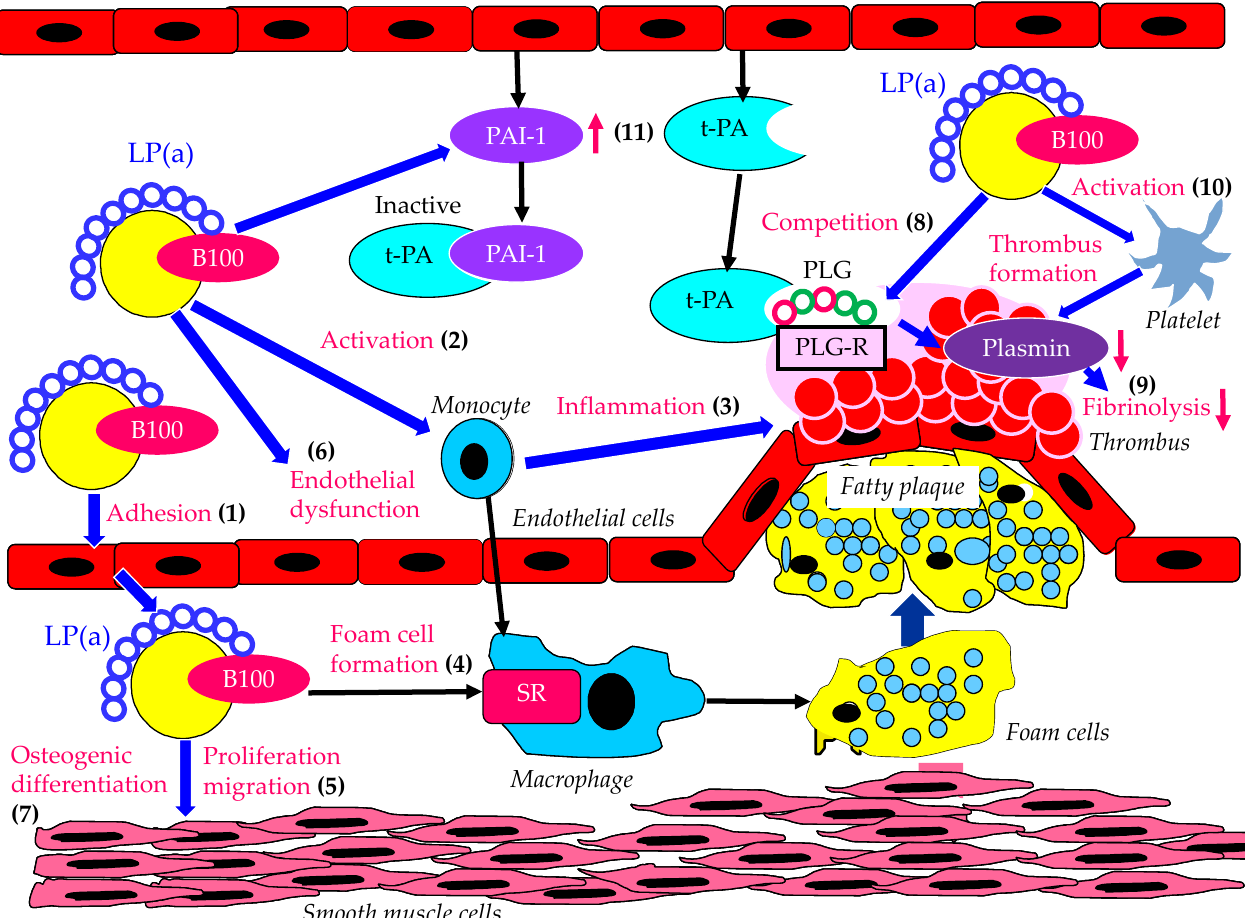
Figure 1. Atherogenic and thrombogenic properties of Lp(a). Lp(a): lipoprotein (a); PAI-1: plasmino- gen activator inhibitor-1; PLG: plasminogen; PLG-R: plasminogen receptors; SR: scavenger receptor; t-PA: tissue plasminogen activator.